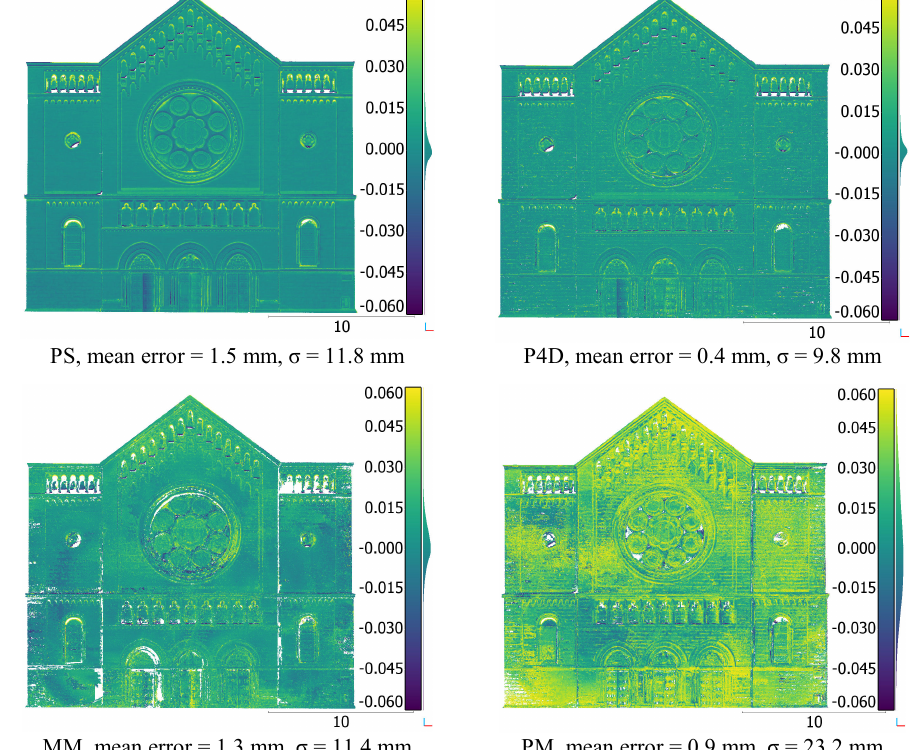
Figure 5. Comparison of dense matching results of the main façade to TLS data.